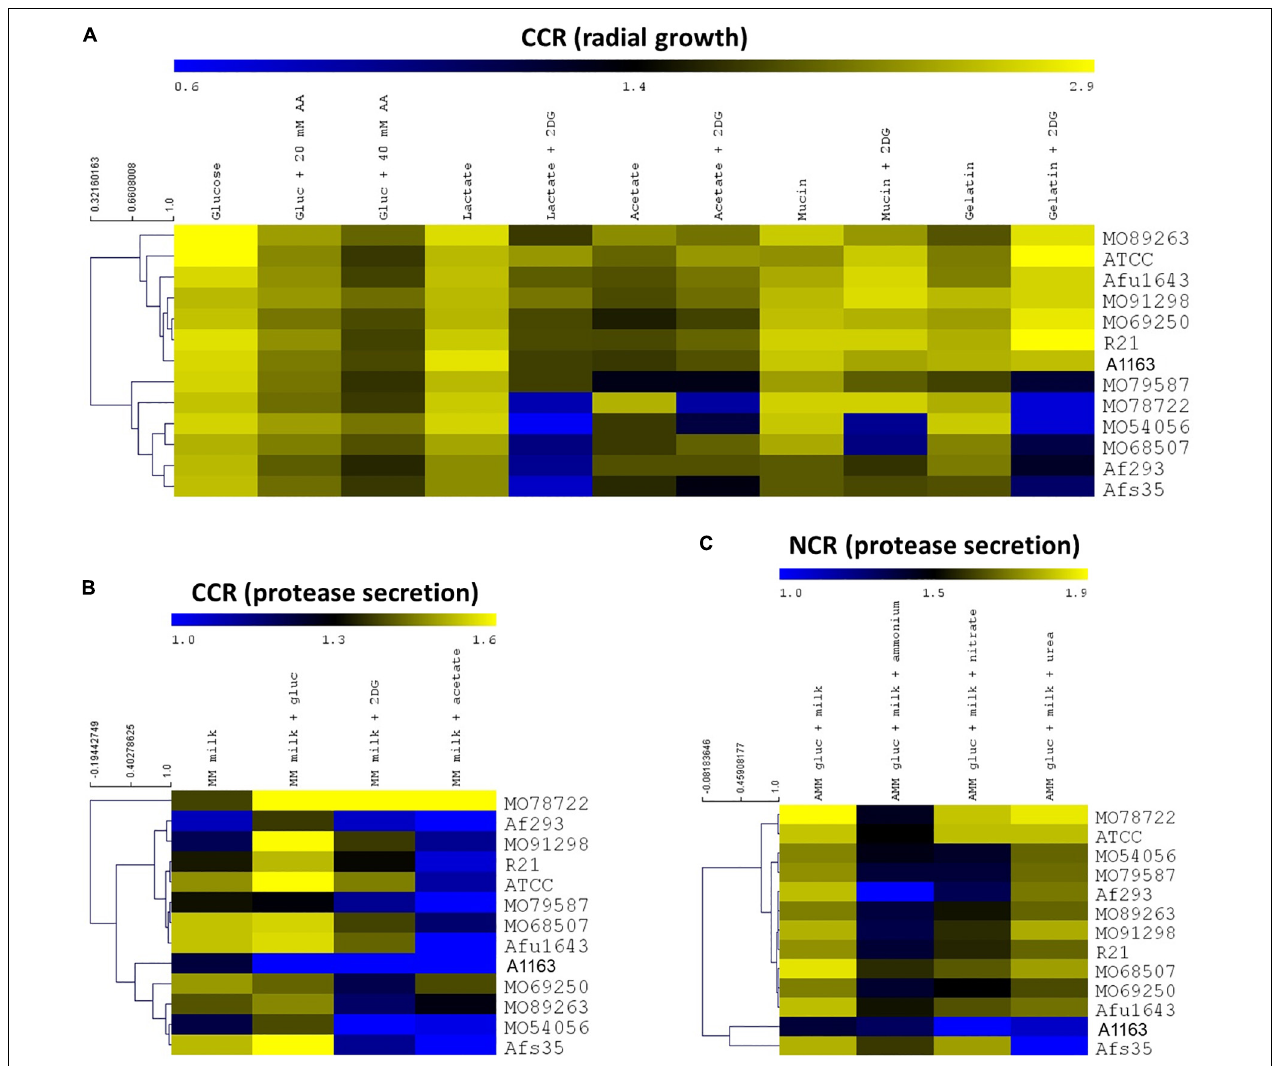
FIGURE 1 | Aspergillus fumigatus clinical isolates show heterogeneous growth and protease secretion in carbon catabolite repressing (CCR) and nitrogen catabolite repressing (NCR) conditions. (A) Colony diameters of strains when grown in the presence of CCR conditions are represented as a heat map. (B,C) Heat maps of protease secretion halo indices when strains were grown in CCR (B) or NCR (C) conditions. Heat maps show the average of two biological replicates (MM, minimal medium; AA, allyl alcohol; 2DG, 2-deoxyglucose; AMM, minimal medium without a nitrogen source). Branches depict the closeness of strains based on the aforementioned growth or protease secretion